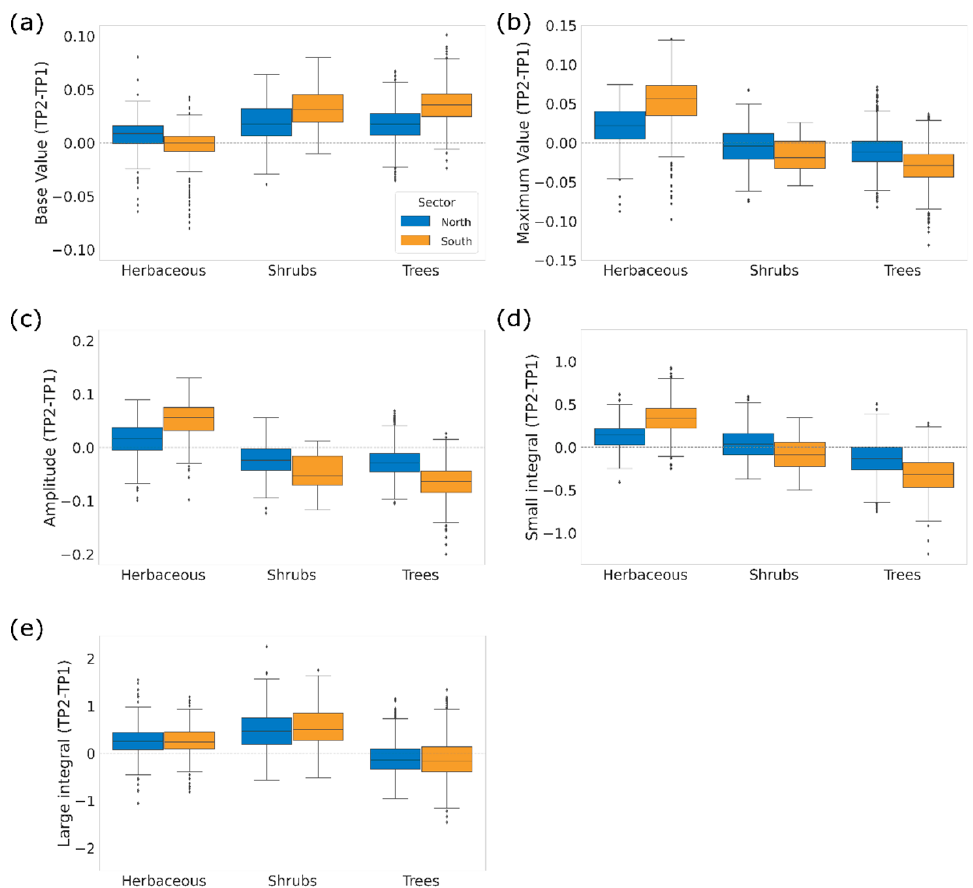
Figure 4. Distribution of differences in productivity metrics between the two study periods for the pixels in each sector (north sector in blue, south sector in brown) and for each vegetation type. Positive values indicate an increase in base value ( a ), maximum value ( b ), amplitude ( c ), small integral ( d ), and large integral ( e ) from the first two seasons to the last two seasons. Negative values indicate a decrease, values close to zero indicate little or no change. TP1—Time Period 1 (seasons 1–2), TP2—Time Period 2 (seasons 3–4).